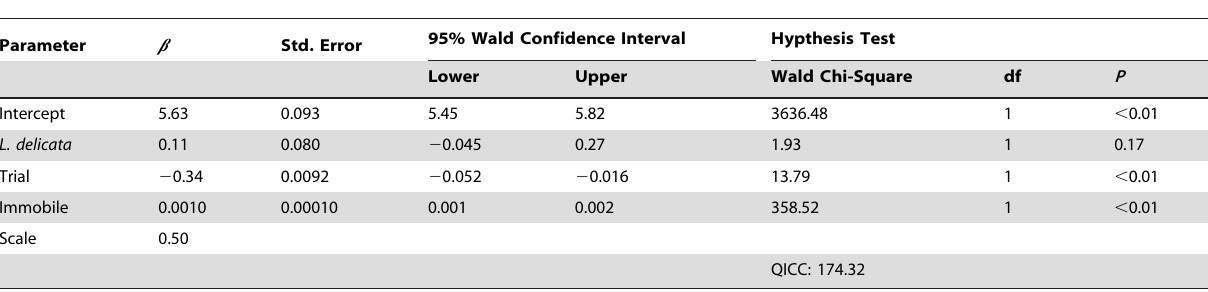
Table 2. Species differences in time spent immobile across 15 maze trials.